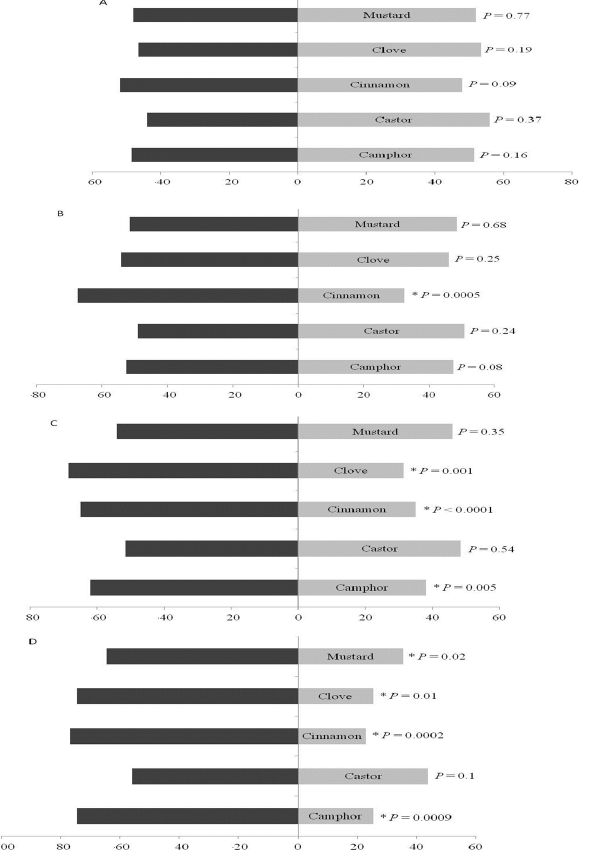
Fig. 1. Preference (%) of Bruchidius incarnatus for a half filter paper treated or not with five essential oils with concentrations (A) 0.5 % (B) 1 %, 2 % and (c) 4 % after 2 h, in free choice test. * Significant values at 5 % probability by t-paired test ( p <